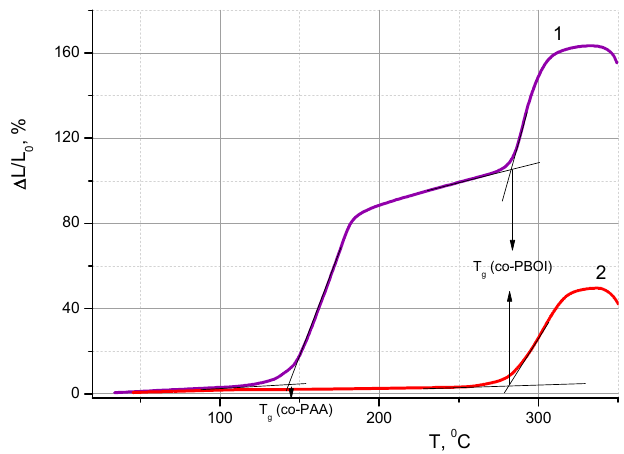
Figure 7. Thermomechanical curves of ( 1 ) co-PAA and ( 2 ) co-PBOI membrane films.